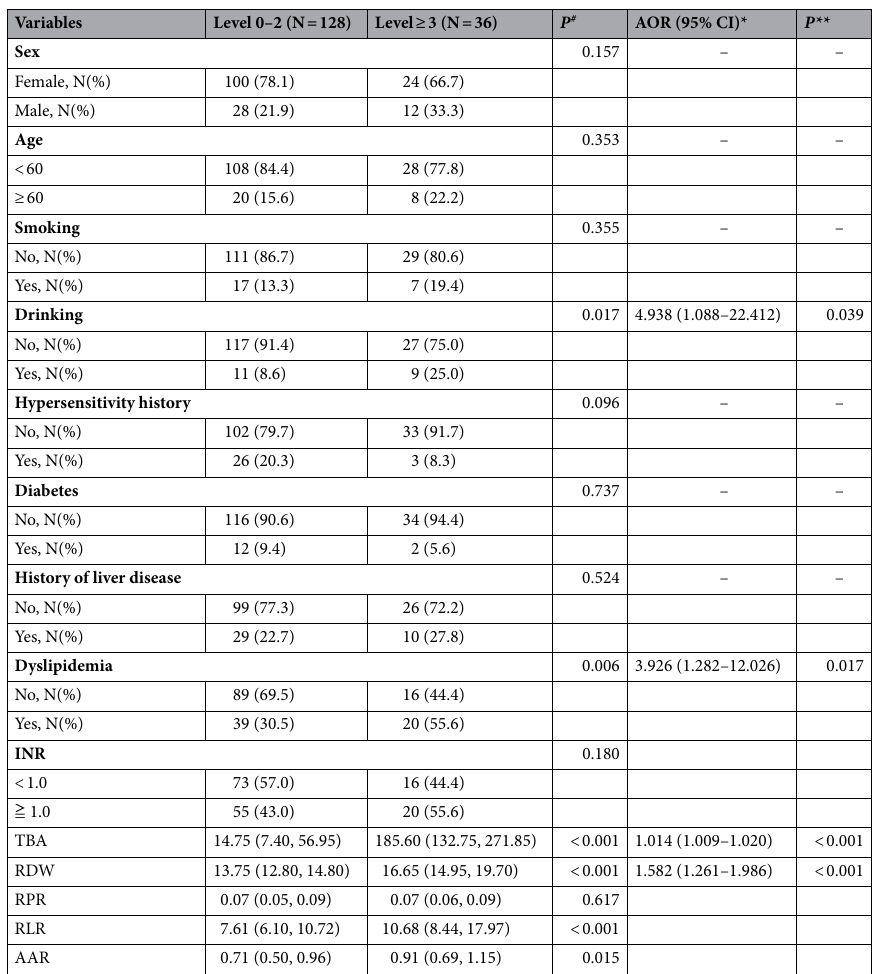
Table 5. Univariate and multivariate analyses of variables associated with severe drug-induced liver injury. Continuous variables are expressed as median (25th, 75th percentiles). Categorical variables were displayed as numbers and percentages. INR international normalized ratio, RLR red blood cell distribution width to lymphocyte ratio, RPR red blood cell distribution width to platelet ratio, AAR aspartate aminotransferase to alanine aminotransferase ratio. # P value for univariate analysis. *Adjusted for sex, age, smoking, drinking, allergic history, DM, hyperlipemia, history of liver disease, TBA, RDW, RPR, RLR, and AAR. ** P value for multivariate